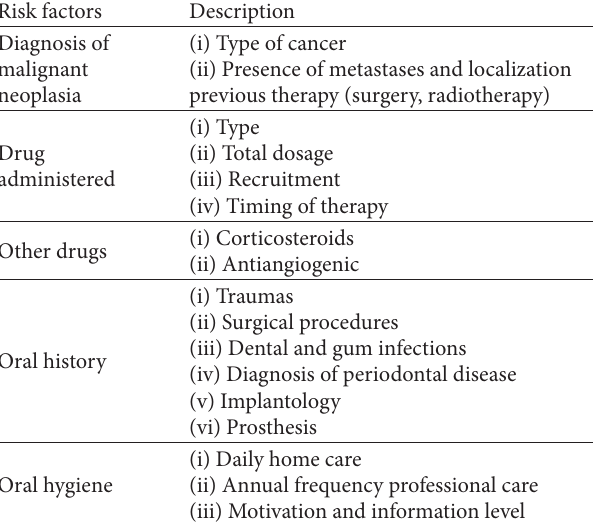
Table 2: Information to identify the risk factors for the development of BRONJ